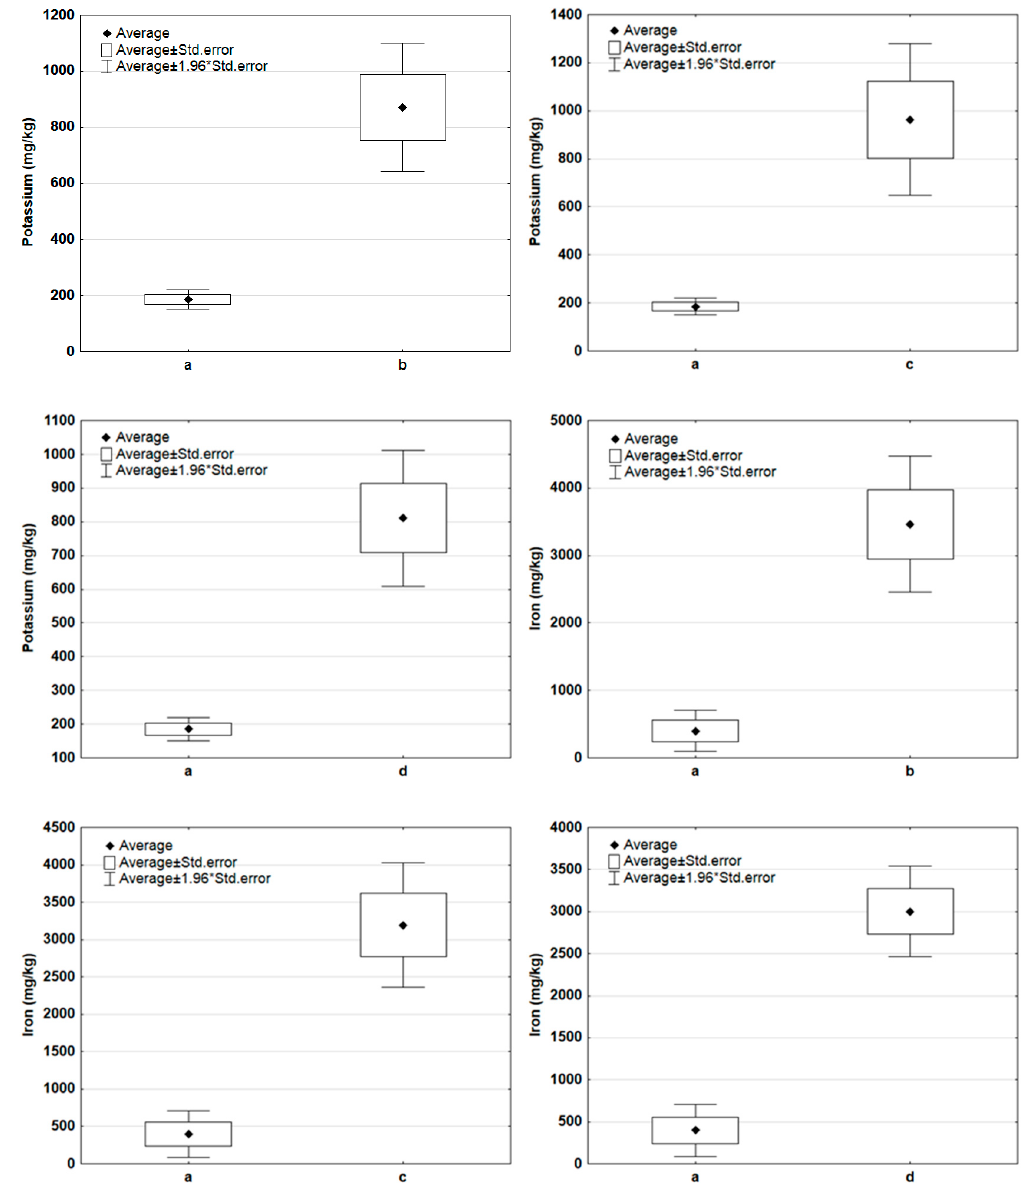
Figure 6. Comparison of basic statistics (mean, standard error) for potassium and iron content in the tested sample groups ( a —new samples, b —composted samples without irradiation, c —composted samples irradiated for 20 h, d —composted samples irradiated for 50 h).